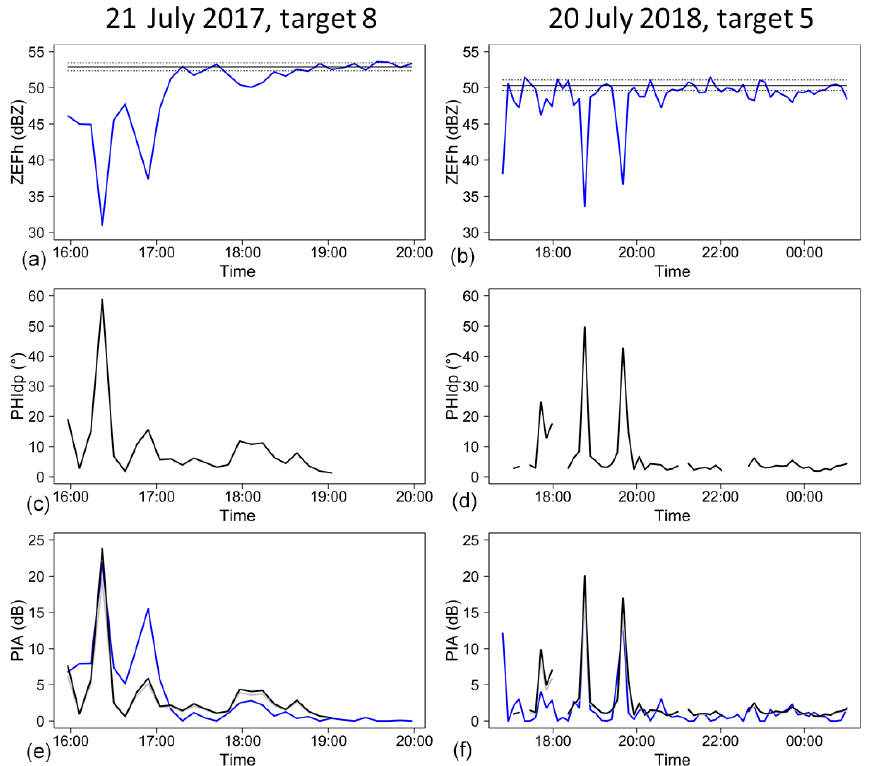
Figure 5. Two examples of time series of the apparent reflectivity of mountain returns for a given target (a, b) , the corresponding (cid:56) dp estimates (c, d) , and the resulting PIA estimates. The horizontal black lines in the top graphs represent the mean (solid line) and the 10% and 90% quantiles (broken lines) of the dry weather apparent reflectivity of the target. The three lines in (e) and (f) correspond to the MRT PIA estimates (blue) and to the polarimetry-derived PIA estimates by using the linear k – K dp relationship (gray) and the nonlinear k – K dp relationship (black) derived from DSD measurements at ground